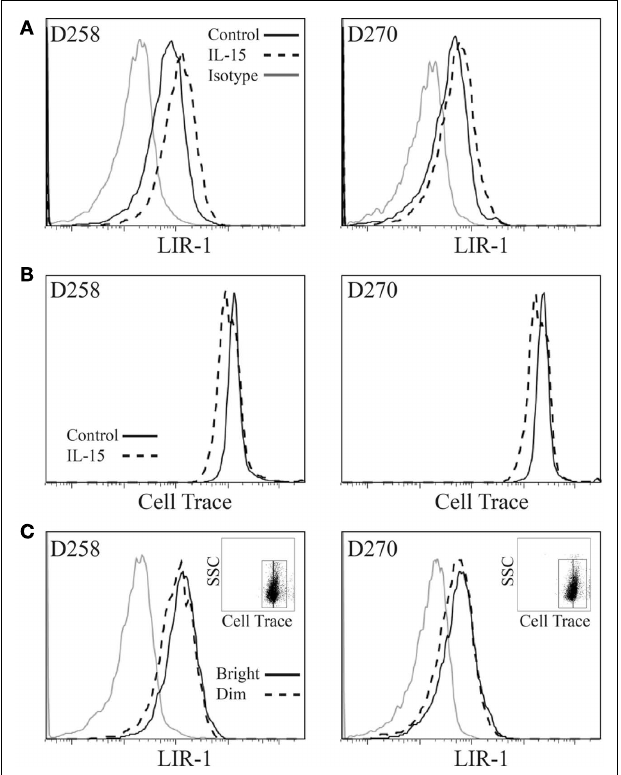
FIGURE 6 | Leukocyte Ig-like receptor 1 bright NK cells do not proliferate preferentially in vitro . Expanded NK cell populations were labeled with CellTraceViolet proliferation dye and then placed in culture in the presence of IL-15 plus low dose IL-2 or low dose IL-2 alone (control) for 72h and examined by flow cytometry. (A) LIR-1 expression profiles. (B) CellTrace signal for the same samples as in (A) . (C) LIR-1 expression profiles for the IL-15 stimulated NK cell populations depicted in (B) divided into CellTrace Violet bright and dim populations as shown in insert panel. Representative results from experiments with D258 and D270 are shown ( n ≥ 3).